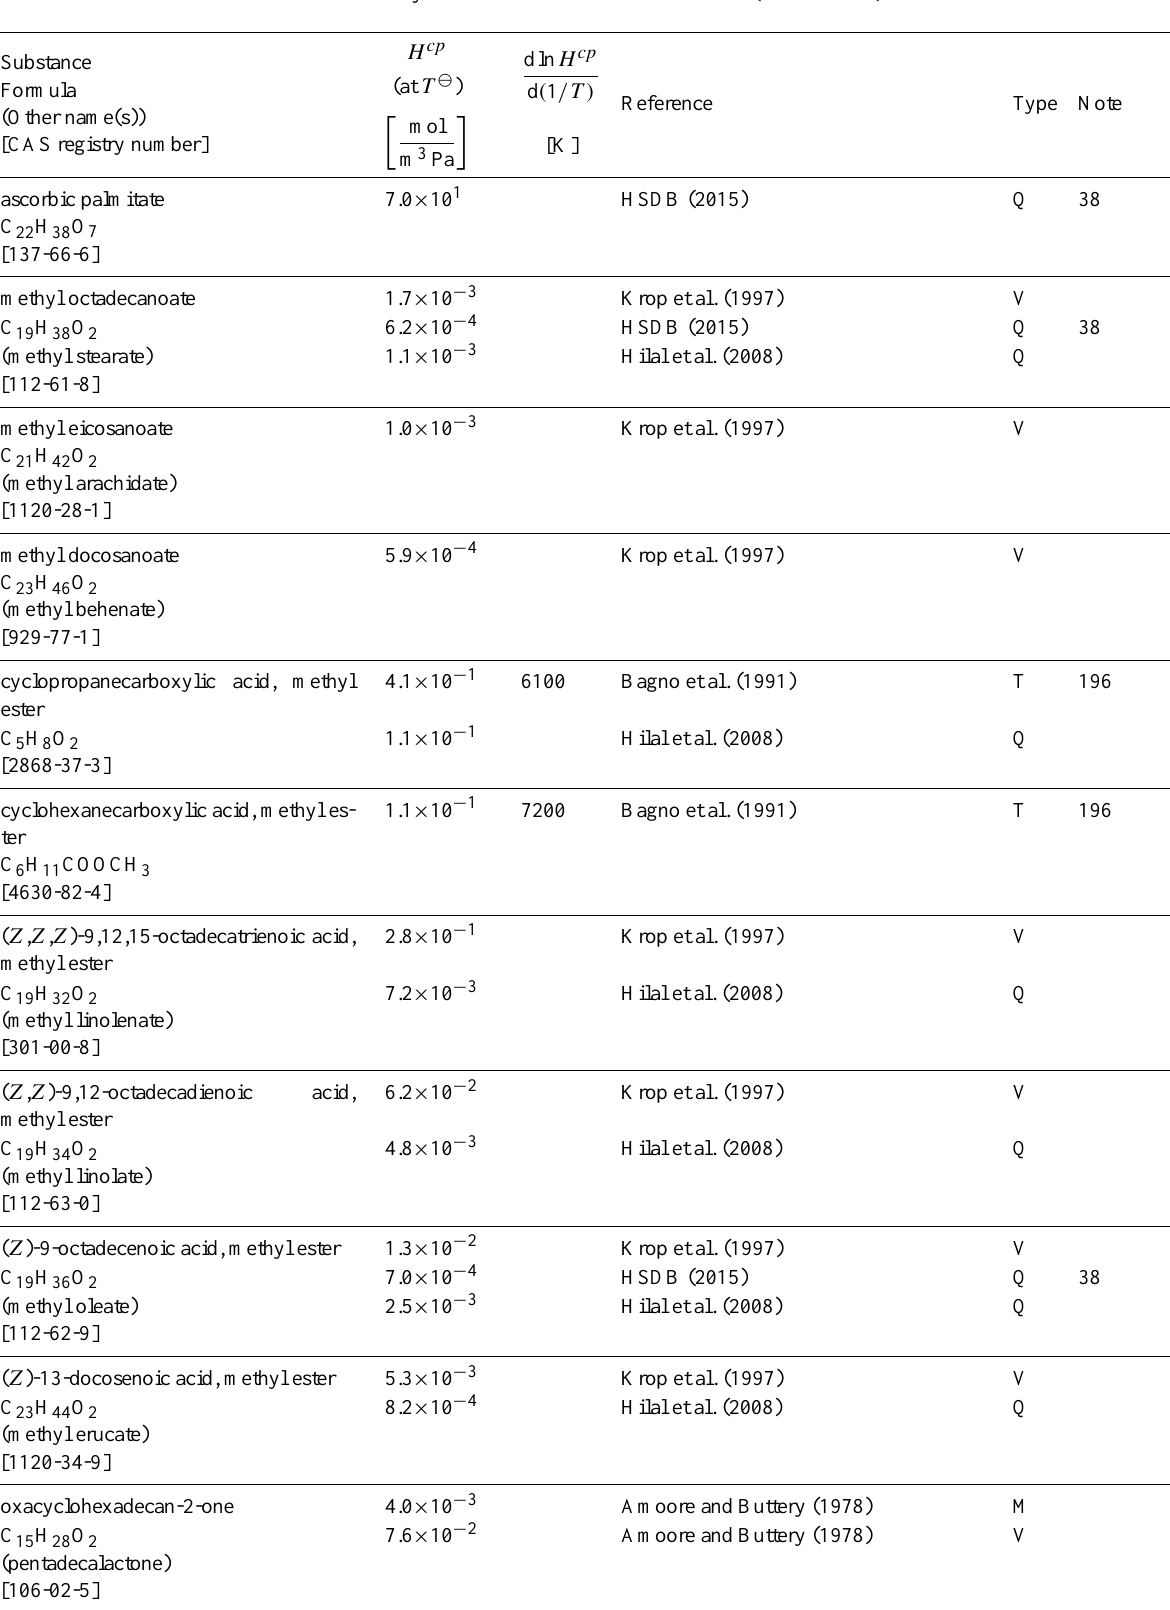
Table 6: Henry’s law constants for water as solvent